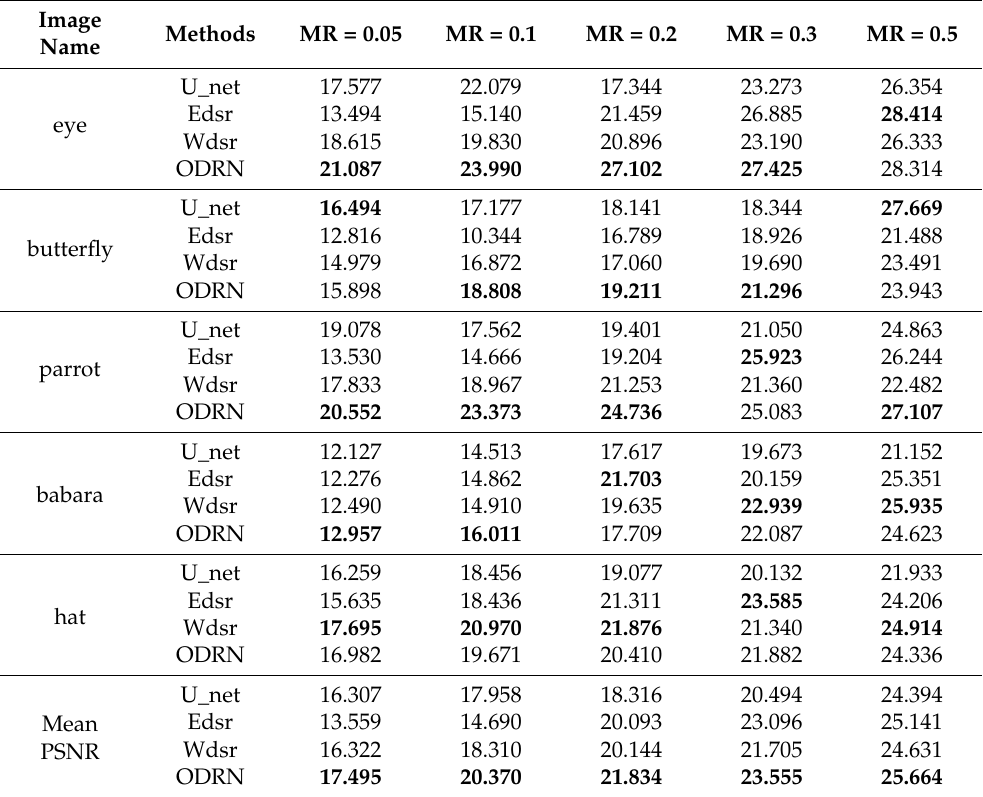
Table 1. PSNR of reconstruction results at different measurement rates when DPAP uses different DIP reconstruction